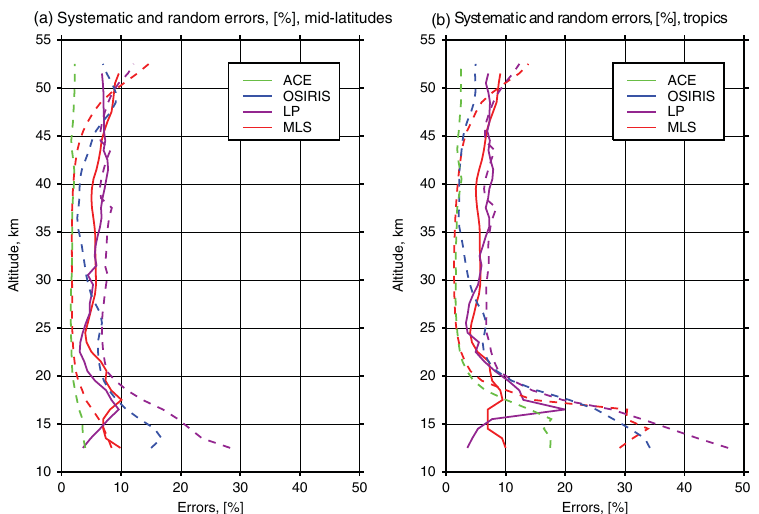
Figure 2. Systematic and random errors for satellite ozone retrievals in the midlatitudes (a) and tropics (b) . Different colors correspond to various satellite instruments. Dashed lines show random measurement errors (retrieval precisions) for all considered satellite instruments. Solid lines show known, reported systematic errors for OMPS LP version 2.5 and MLS version 4 ozone retrievals in percent from the